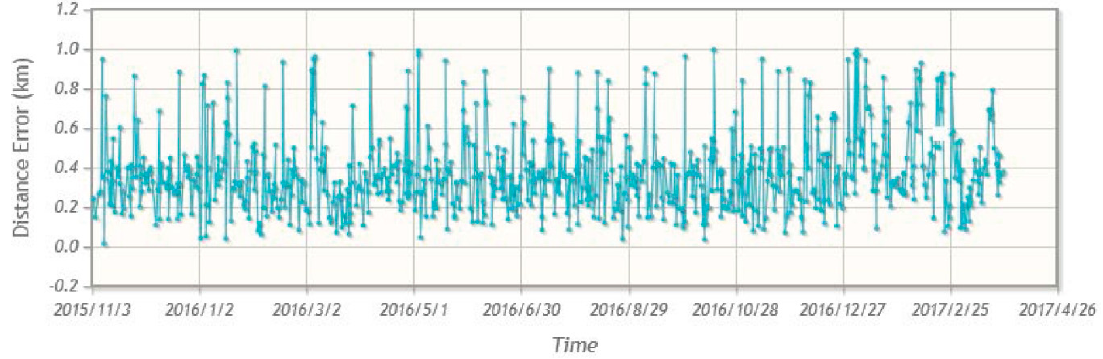
Figure 4. VIIRS DNB geolocation errors at the Oil Platform Holly site.